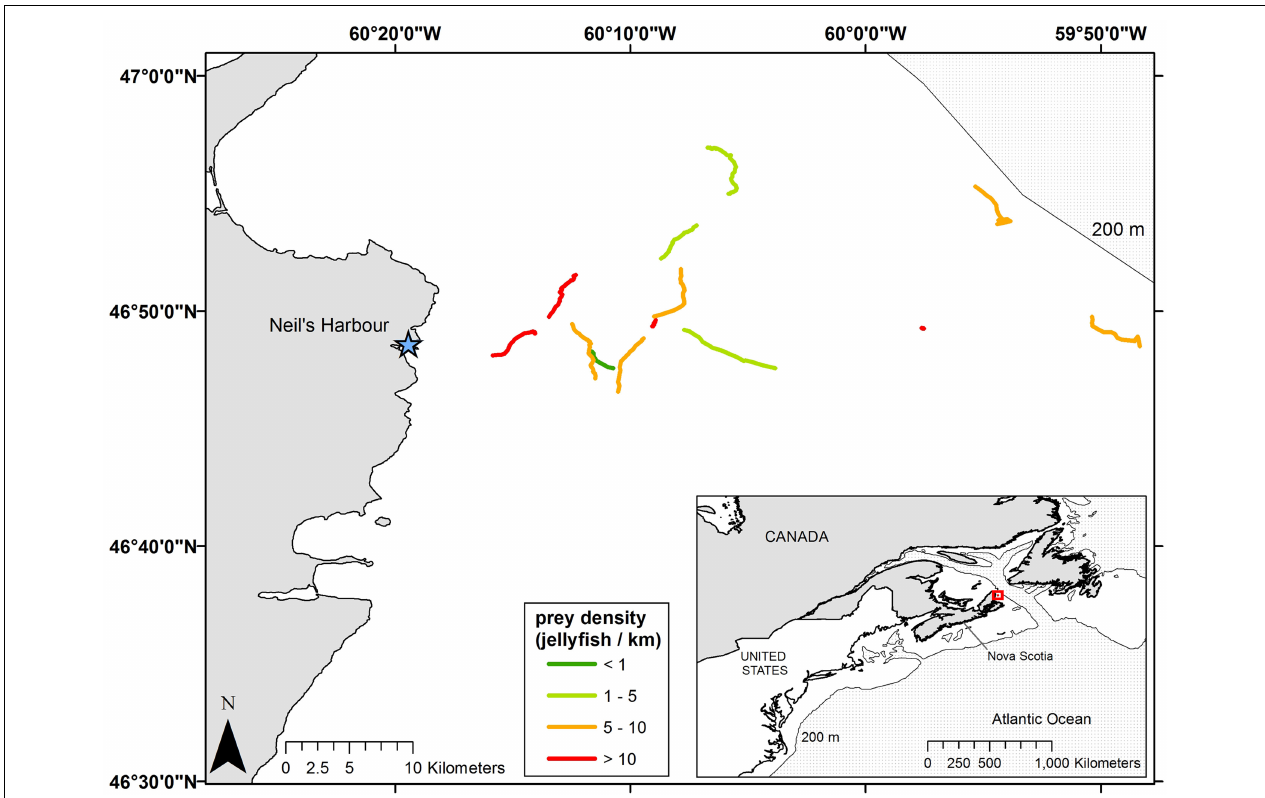
FIGURE 1 | Tracklines of leatherback turtles ( Dermochelys coriacea ) foraging in the Northwest Atlantic Ocean off Neil’s Harbor, Nova Scotia, Canada, during 2008–2013 ( n = 12). Tracks are coded to show variation in prey density (number of jellyfish sighted km − 1 traveled); there were no among-year differences in prey densities. Prey sightings were